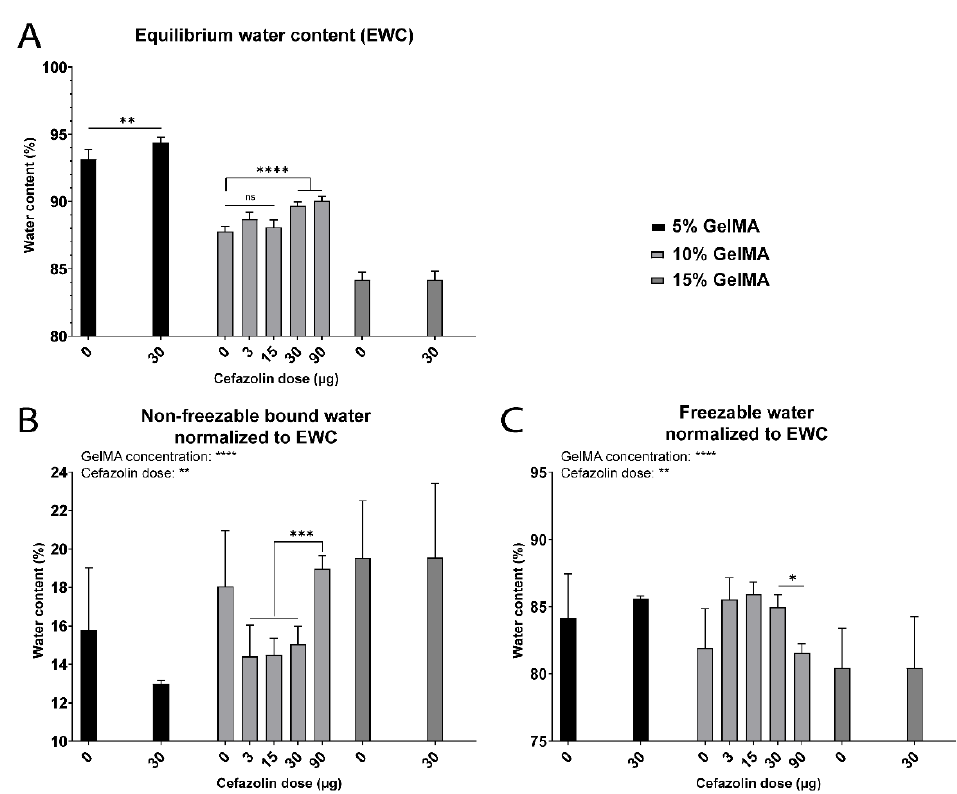
Figure 11. Water content and water types for GelMA hydrogels (5% to 15% gel fraction) crosslinked with 0, 3, 15, 30 or 90 µg cefazolin in PBS. Hydrogels were analyzed just after crosslinking. ( A ) Equilibrium water content ( EWC ) (%) ( n = 5). ( B ) Non-freezable bound water ( W nfb ) (%) normalized to the EWC ( n = 3). ( C ) Freezable water ( W f ) (%) normalized to the EWC ( n = 3). Ns = non-significant; * = p < 0.05; ** = p < 0.01; *** = p < 0.001; **** = p < 0.0001.